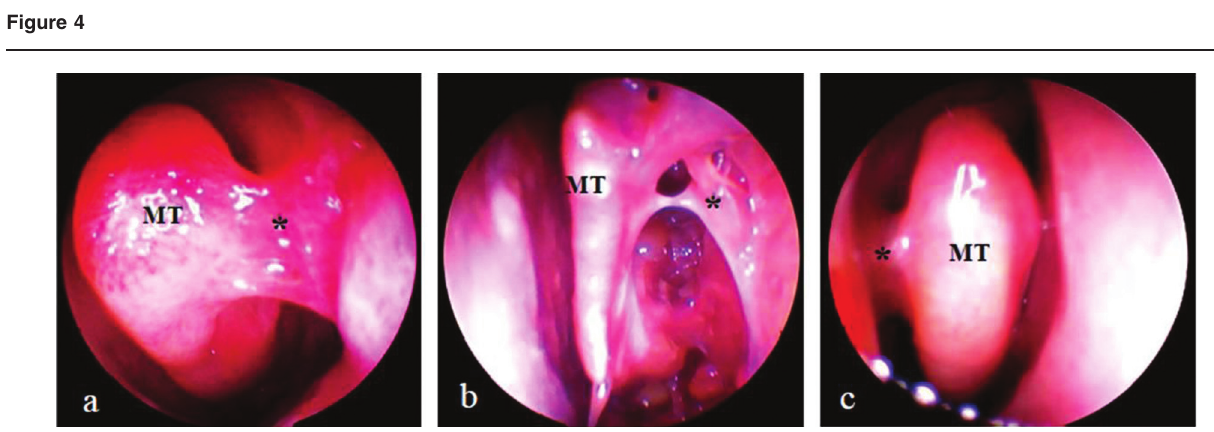
Nasal endoscopy showing: (a) nonobstructing synechia (*) 1-month postoperatively in Gelfoam packed on the left side. (b) Nonobstructing synechia (*) in Surgicel packed on the left side 1-month postoperatively. (c) Obstructing synechia (*) in Merocel packed on the right side 1-month